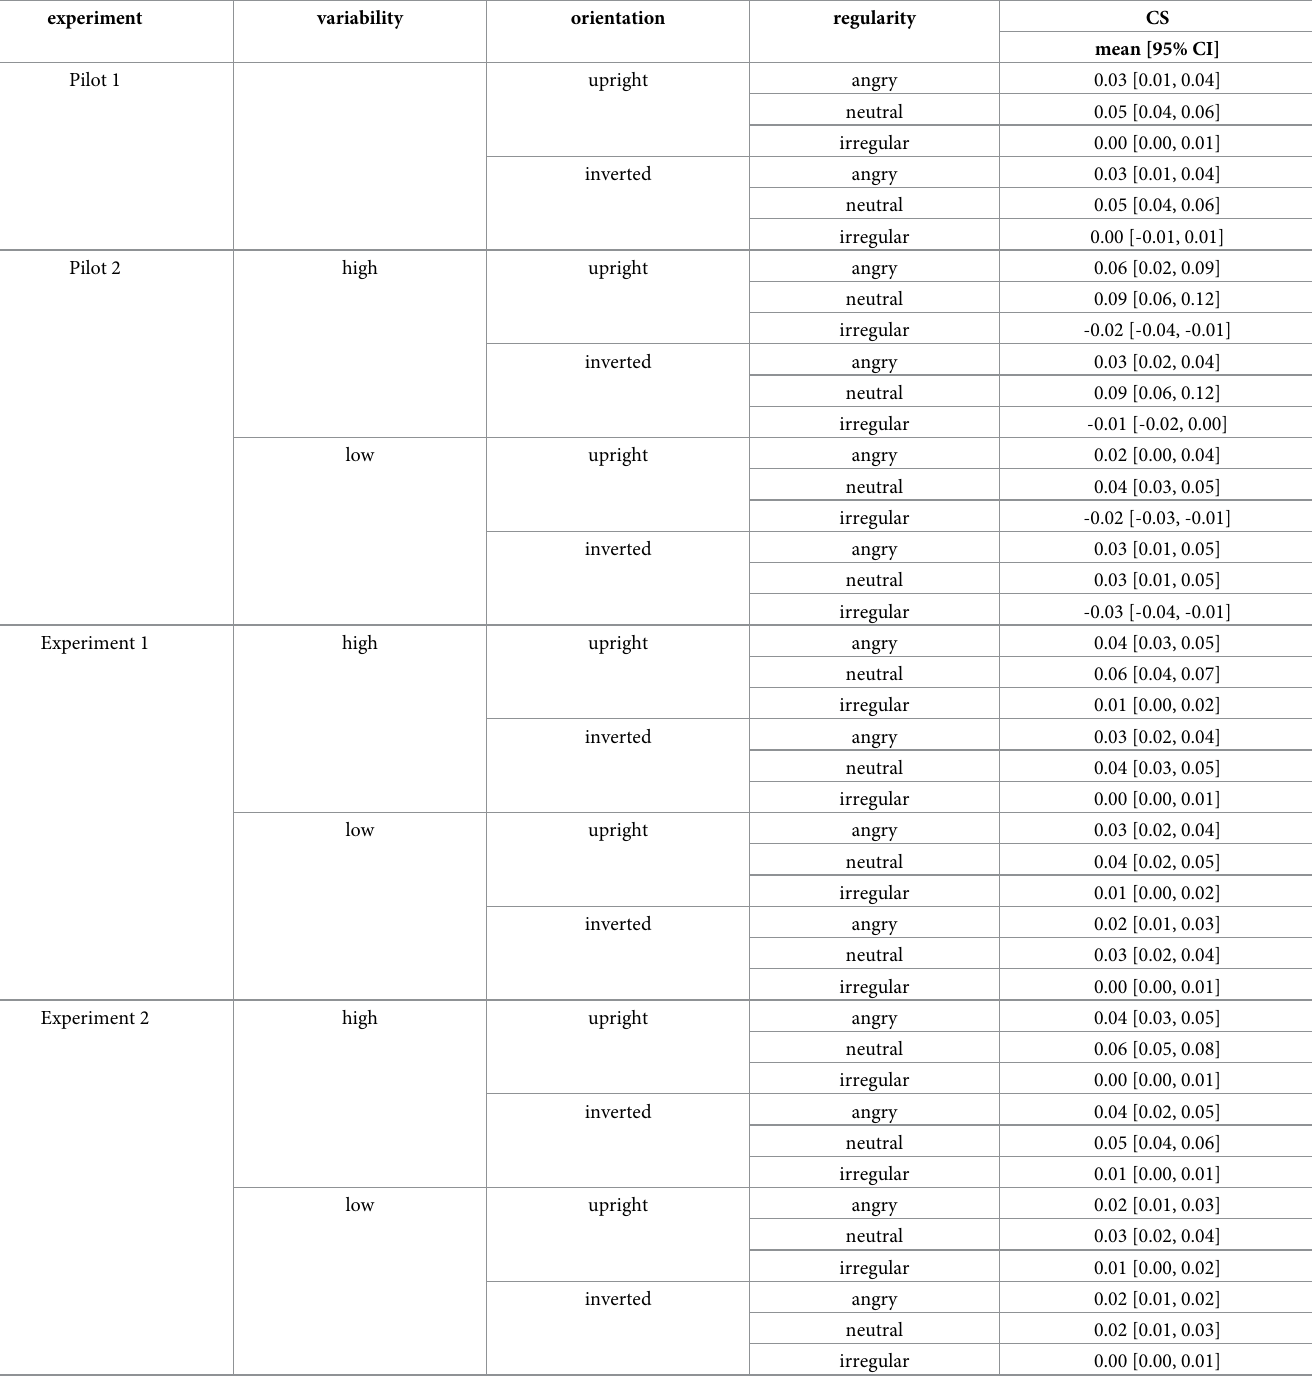
Table 2. Cosine Similarity Index (CS), regularity